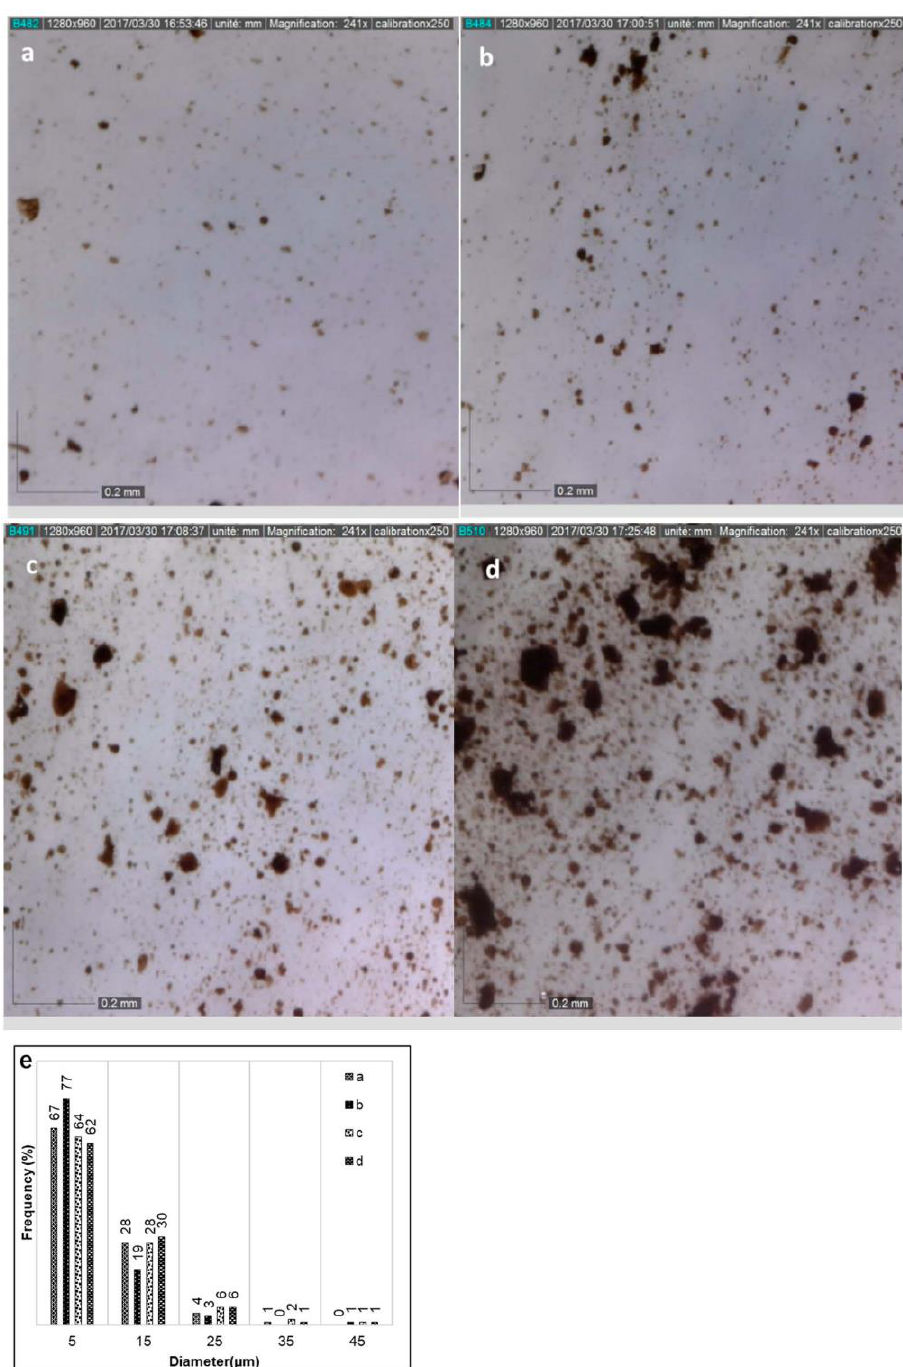
Figure 2. Micrographs of PP/TH composites: ( a ) 5TH, ( b ) 10TH, ( c )15TH, ( d ) 30TH, ( e ) particles size distributions.